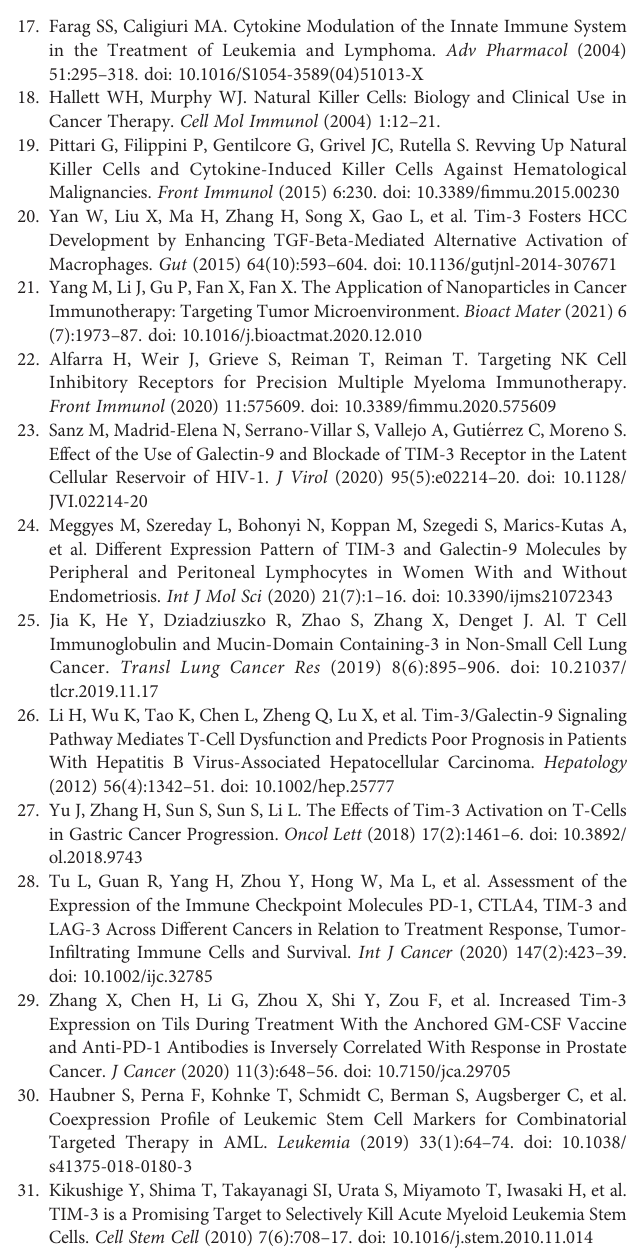
Supplementary Figure S1 | The expression of Tim-3 ligands in exNK cells and NKcelllines.Tim-3ligandsexpressionwerequanti fi edby fl owcytometry. (A-C) The expression of Tim-3 ligands in exNK, NK-92 and NKL cells. Supplementary Figure S2 | Tim-3 expression in MM cell lines. Tim-3 expression werequanti fi edby fl owcytometry.FigureshowedtheexpressionofTim-3ligandsin MM cell line RPMI8226 and MM.1S